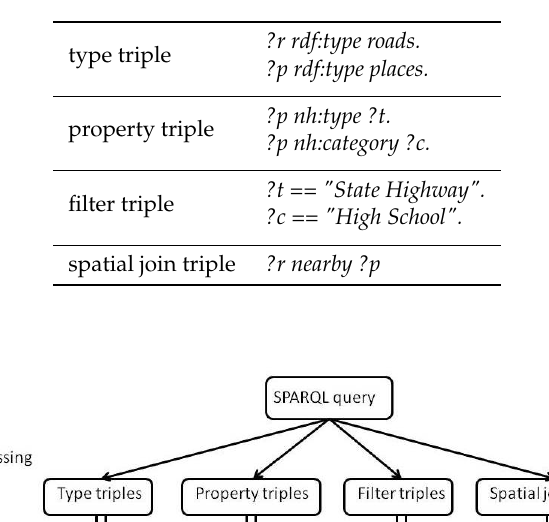
Table 1. Separated triples of Query (2).